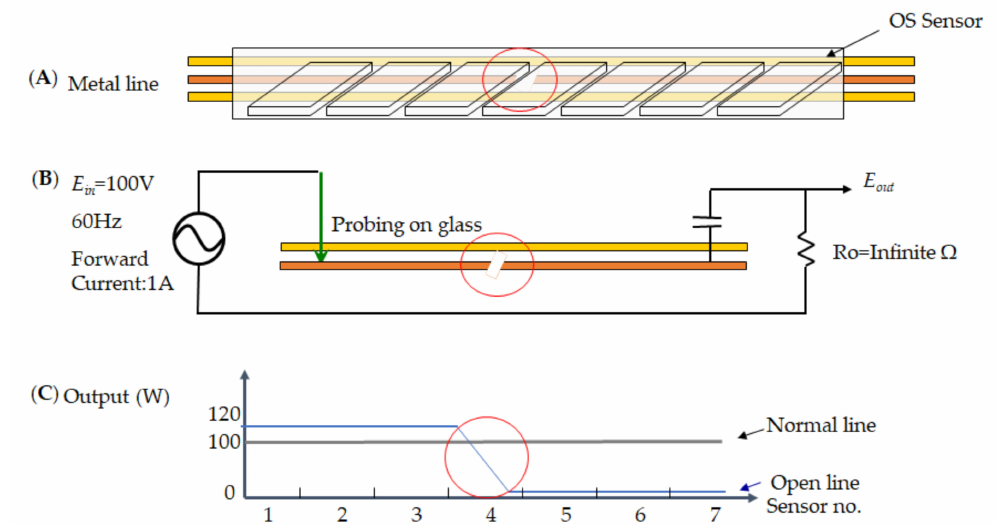
Figure 7. An open defect presents on the electrical signal for thin-film-transistor (TFT), which ( A ) metal line, ( B ) measure- ment voltage, and ( C ) power distribution.